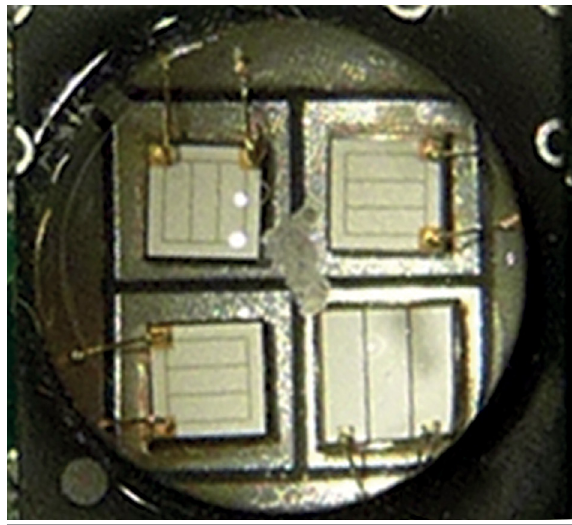
Figure 30. Image of the construction of the emitting elements of a 4 element combination LED array: only the lower left chip emits violet light – the others emit blue light.